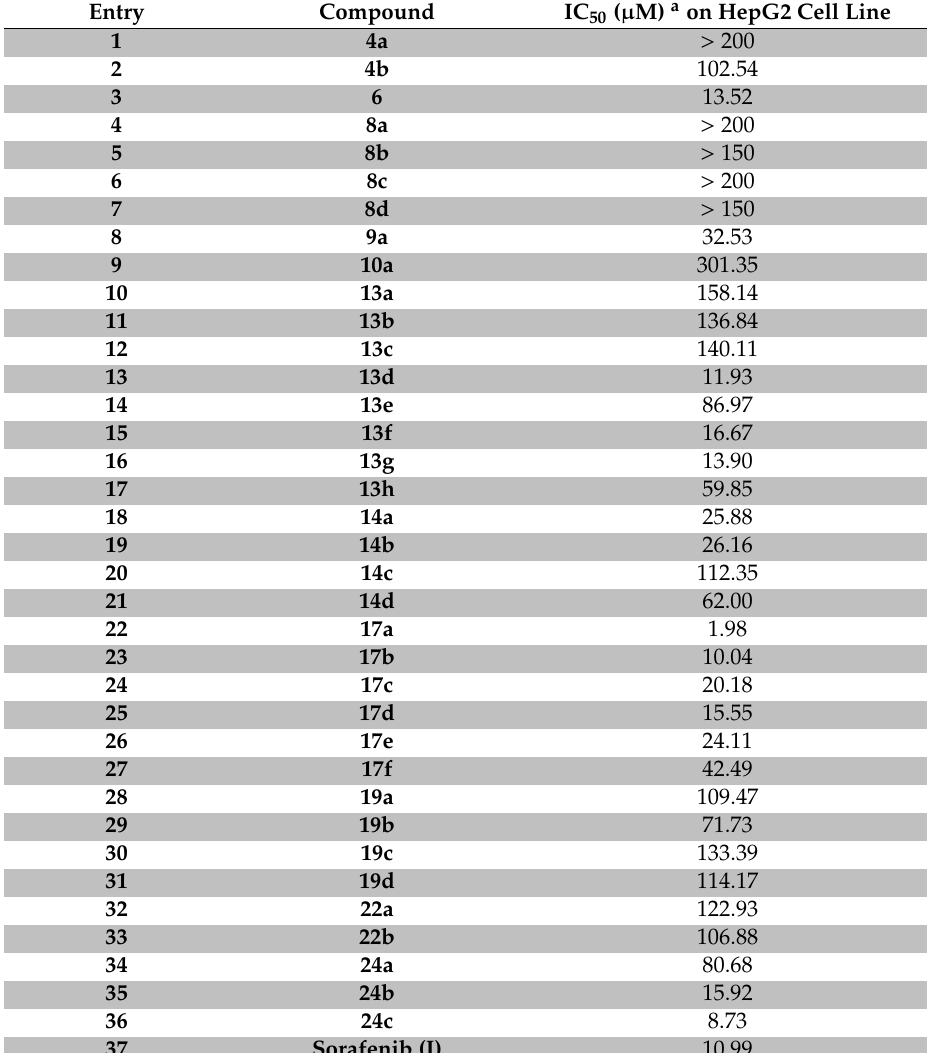
Table 1. Results of the in vitro cytotoxic activity of benzimidazoles against the HepG2 cell line. Entry